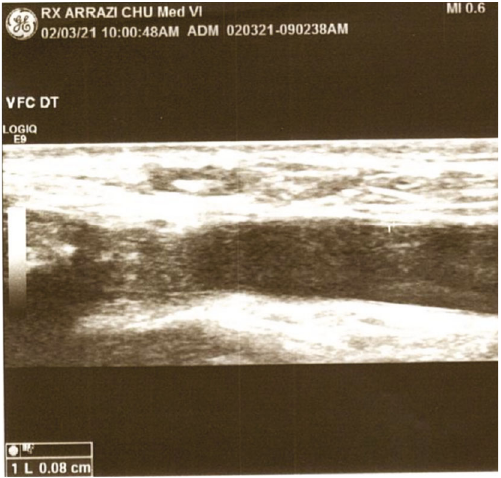
Figure 3: Image showing sonographic measurement of the thickness of the right common femoral vein wall at 0.8 mm.